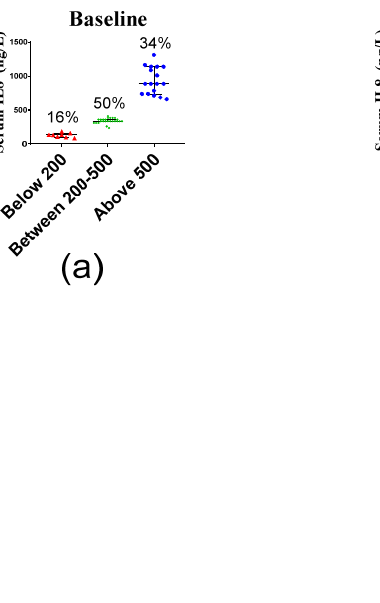
Figure 5. Serum IL8 levels before and after vitamin D supplementation: ( a ) baseline levels, ( b ) day 1 levels, and ( c ) day 30 levels. ( d ) Columns represent the median serum IL6 concentration at baseline, day 1 and day 30, and error bars indicate interquartile range. Data were analyzed by non-parametric repeated measure ANOVA followed by Wilcoxon signed-rank multiple comparison test, and p values are shown where the difference between days was determined to be statistically significant. *** p <